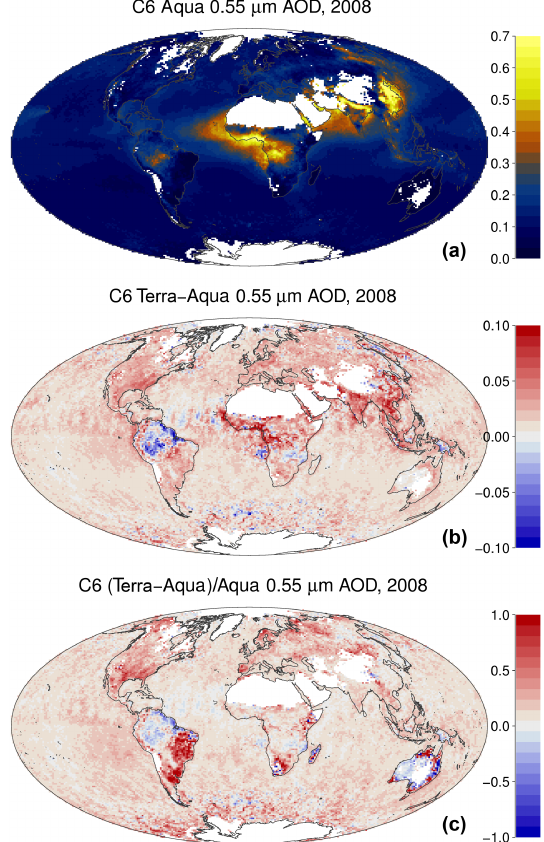
Figure 3. Gridded (0.625 ◦ × 0.5 ◦ ) global mean AOD (at 0.55µm) for 2008, derived from MYD04 (a) , the difference between MOD04 and MYD04 (b) and the relative difference (c)